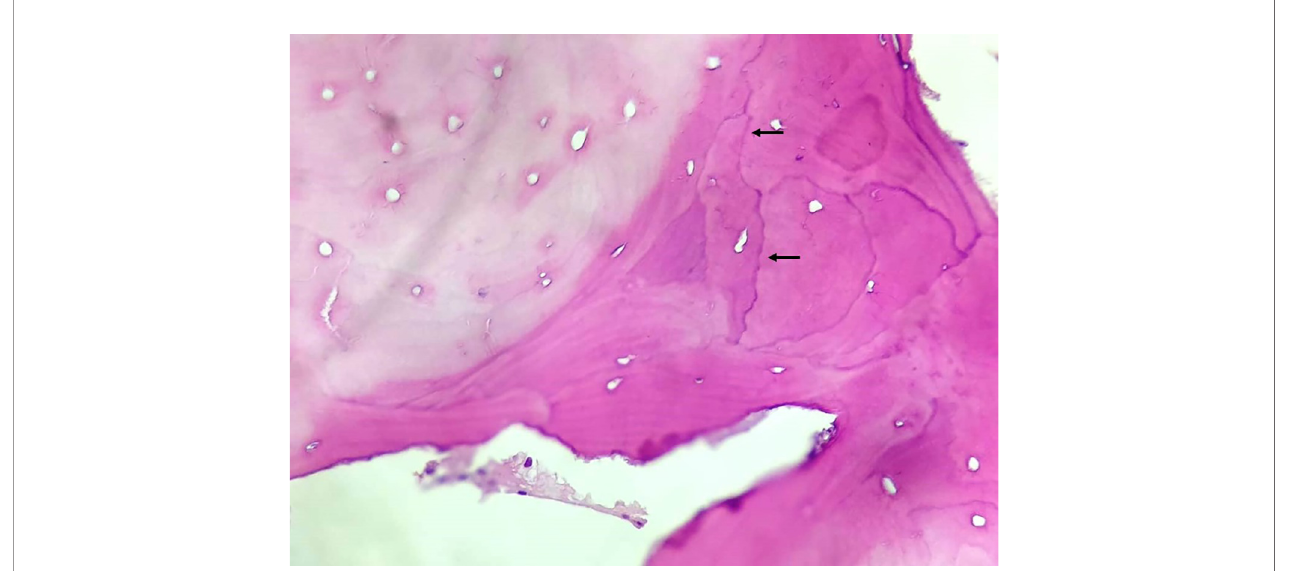
FIGURE 2 | Bone tissue with signs of remodeling. HE stain, magni fi cation 200× … See cement lines